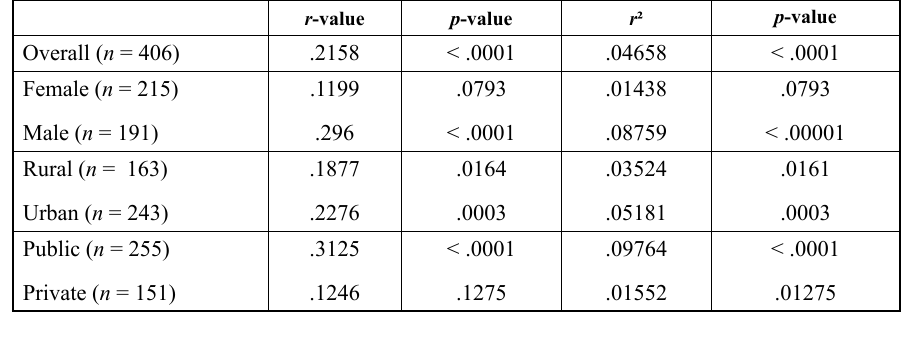
Table 2. Correlation between physical activity (PA) and academic performance (AP) of overall population and different subgroups